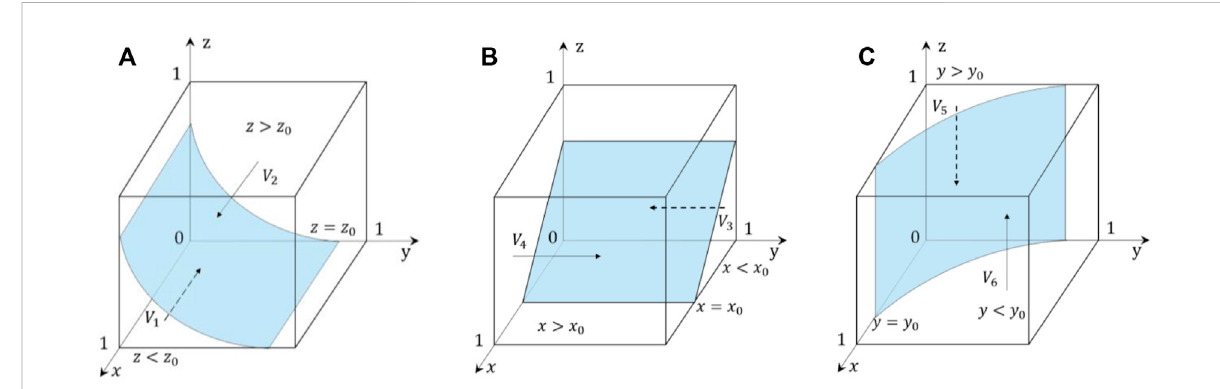
FIGURE 3 Dynamics trend schematic diagram of EVMs, consumers, and the